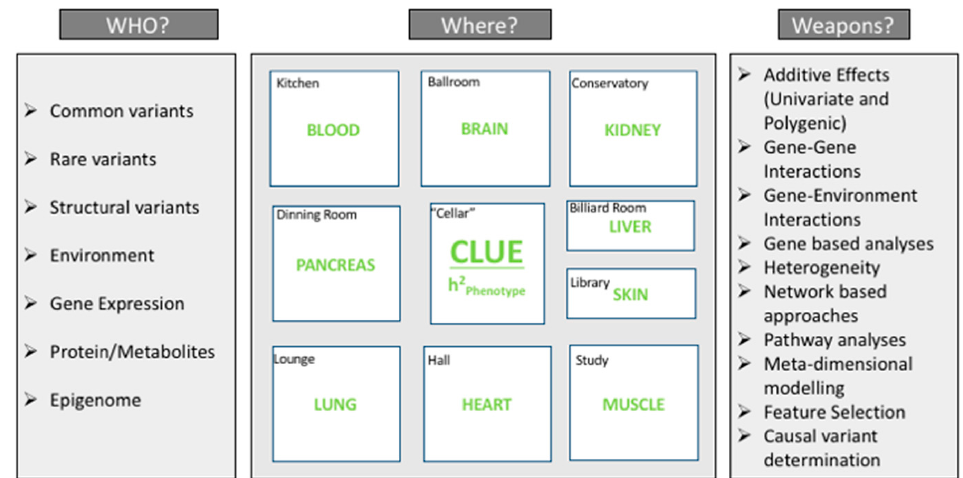
Figure 2. Unriddling undercover heritability. A depiction of the mystery of heritability in the context of the “Game of Clue.” Here, tools and methods to understand heritability are shown as weapons, suspects are genomic elements contributing to heritability, and tissues that are impacted are represented as rooms on the “Clue” game board. The size of rooms does not correspond to importance. This figure is adapted from [43].